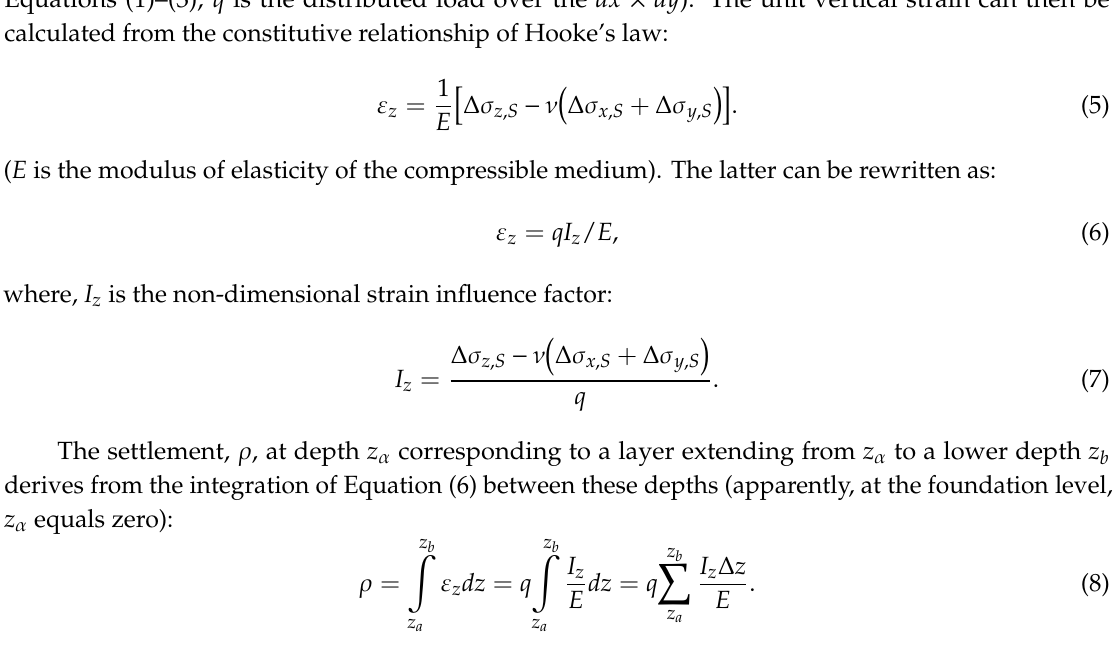
Figure 9. Figures 6 and 7 refer to point “O” and “Q” of the triangular embankment loading of finite length shown in Figure